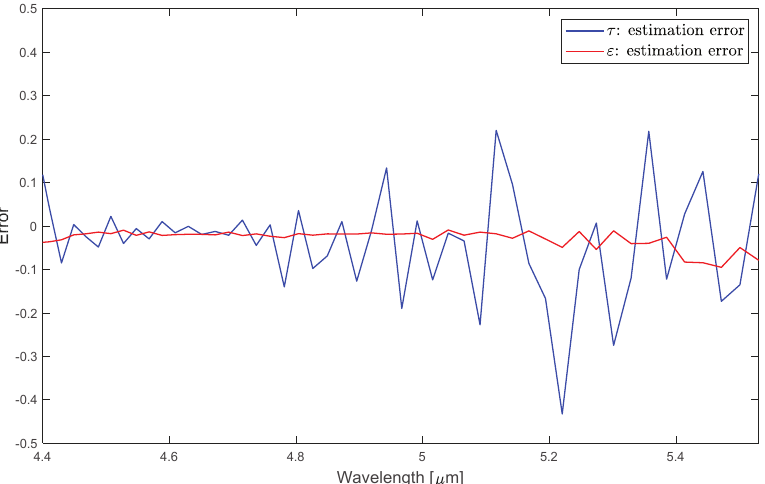
Figure 25. Grass region: Estimation error of spectral atmospheric transmittance and emissivity by the proposed AT 2 ES